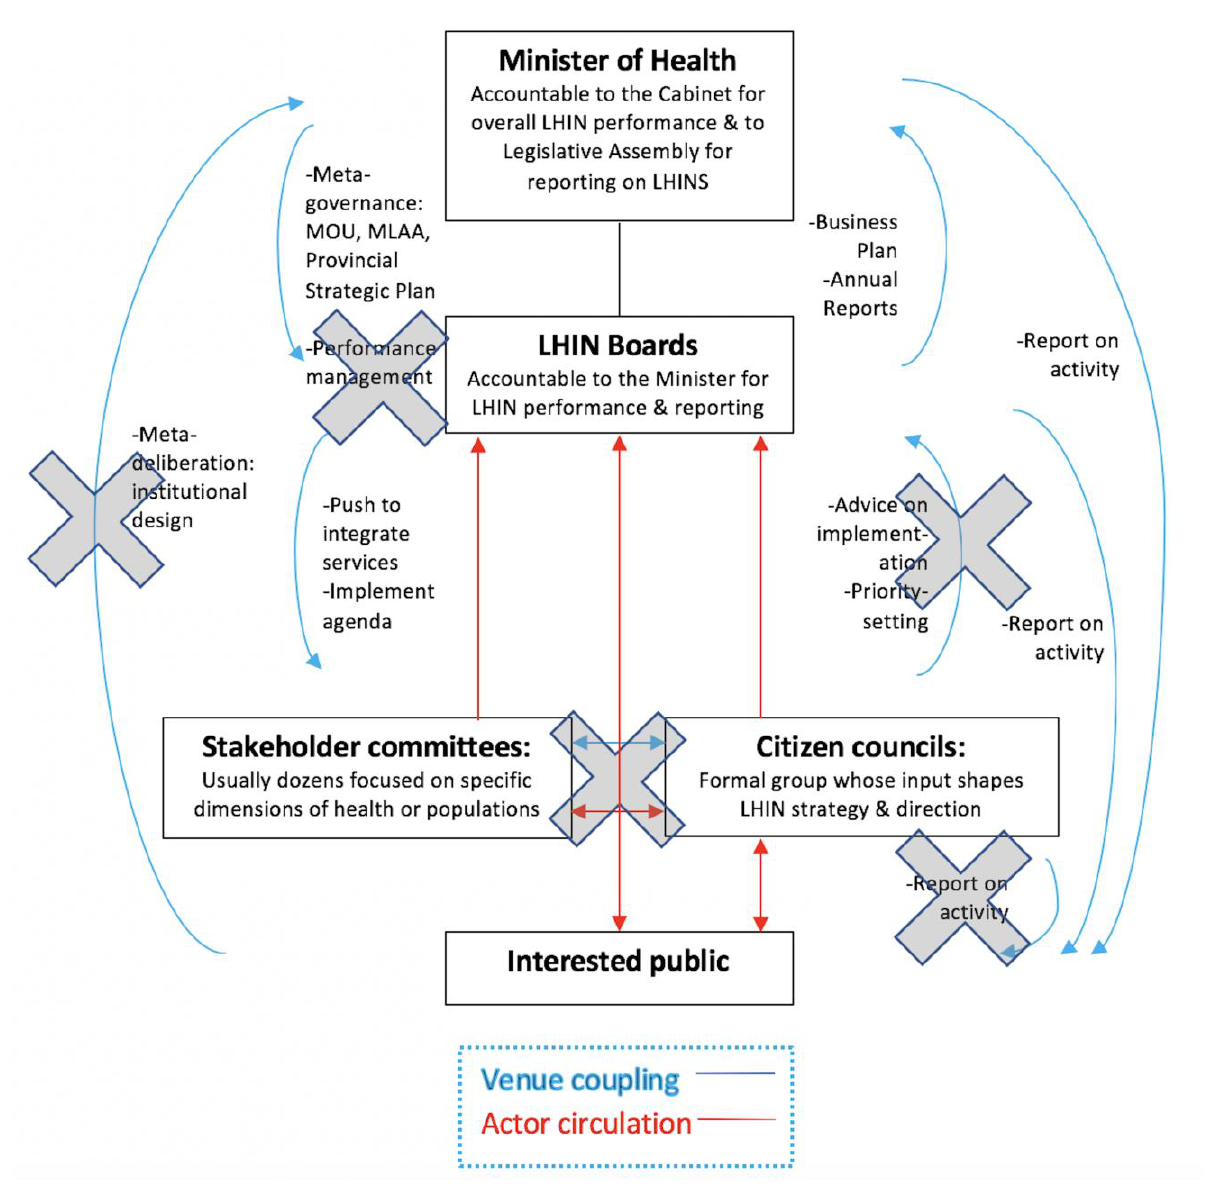
Figure 2 : Chart of authorities and relationships in the LHIN context in practice. Note: Boxes indicate key venues in the LHIN governance system, blue arrows reference elements of venue coupling, and red arrows reference circulation of actors across venues, all as an ideal representation. An X refers to severed venue coupling and actor circulation in